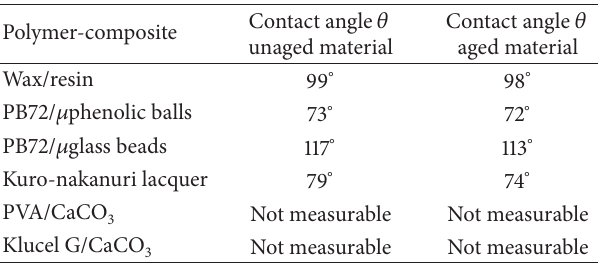
Table 3: Contact angle of a water drop on different polymer- composites.